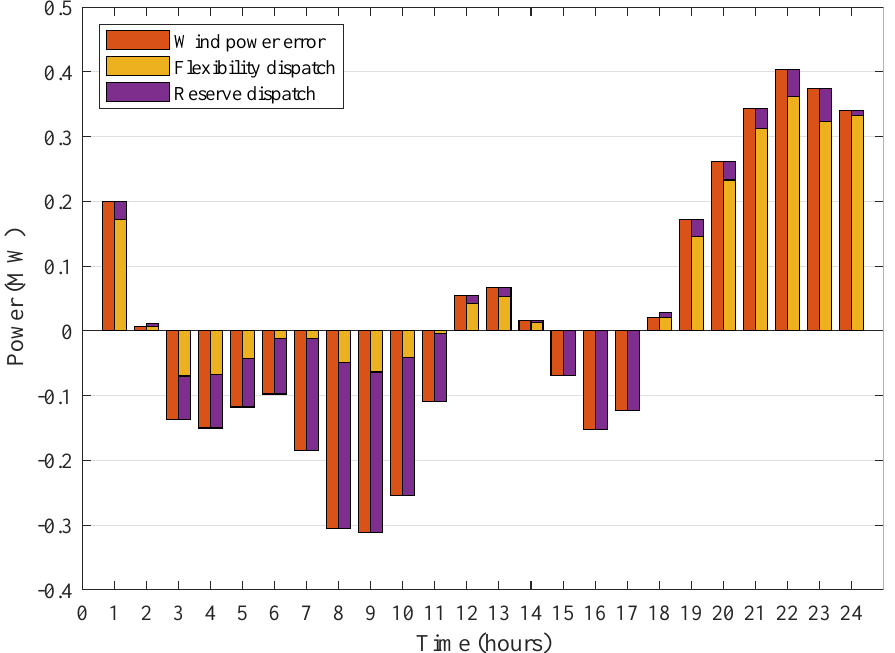
Figure 6. Wind-power error for Case 3, and distribution of reserve and flexibility dispatch. Flexibility dispatch comprises 44.37% of all wind-power error